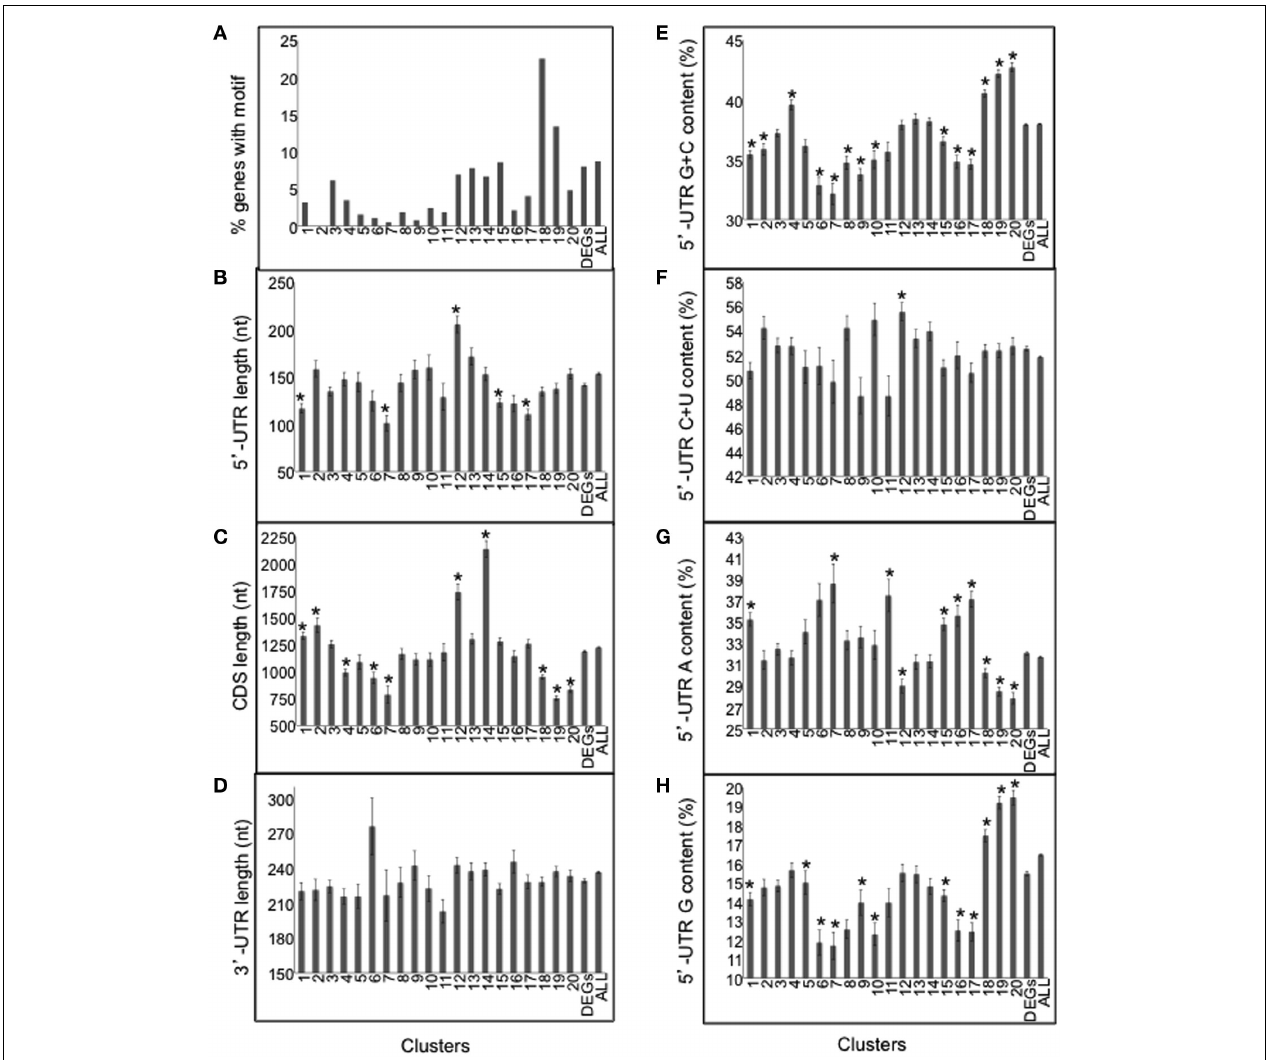
FIGURE 10 | Evaluation of nucleotide sequence features of mRNAs co-regulated by light and/or oxygen availability. (A) Frequency of the motif 5 (cid:2) -[AG][AG]AAACCCUA[AG] resembling a telobox in each of the 20 clusters represented in Figure 9 , the entire DEG dataset, and all 5 (cid:2) -UTRs fromTAIR10 (ALL). (B) Length of the 5 (cid:2) -UTR in nucleotides (nt). (C) Length of the coding sequence (CDS; nt). (D) Length of the 3 (cid:2) -UTR (nt). (E) G + C content (%) of the